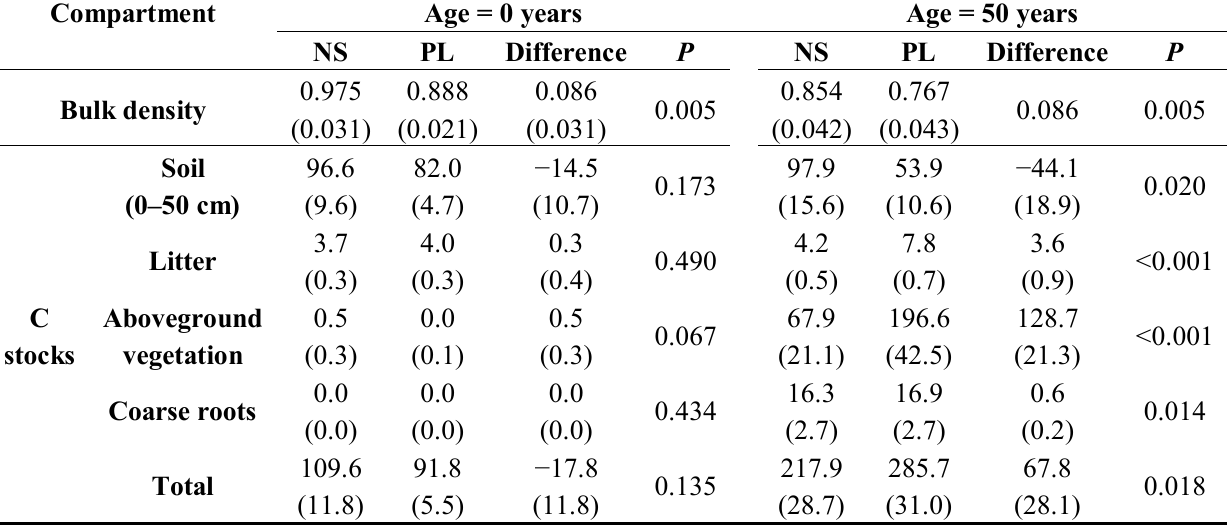
Table 1. Adjusted means of soil bulk density (g cm −3 , 0–50 cm depth) and C stocks (Mg ha −1 , standard error in brackets) in the ecosystem compartments predicted at age 0 and 50 years according to fallow site type (NS: natural succession; PL: plantation). Soil: 0 to 50 cm; litter: litter + herbaceous plants and mosses, live or dead, + coarse woody